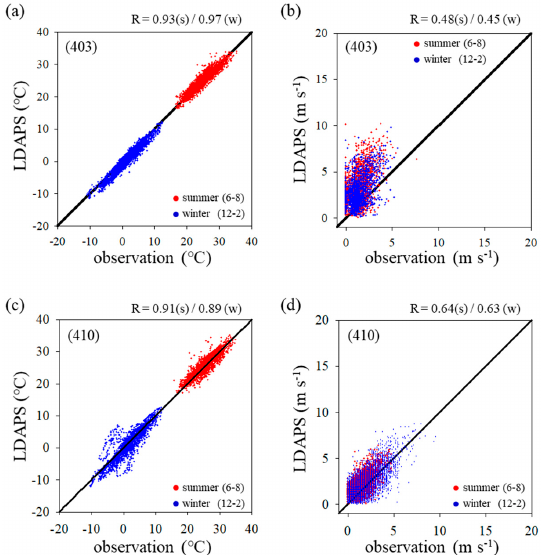
Figure 5. Scatter plots of the AWS-observed and LDAPS-predicted temperatures (left panels) and wind speeds (right panels) at the ( a , b ) AWS 403 (installed on a building roof and ( c , d ) AWS 410 (installed on the ground level). Red and blue dots indicate for summer season (June, July, and August) and winter season (December, January, and February), respectively.